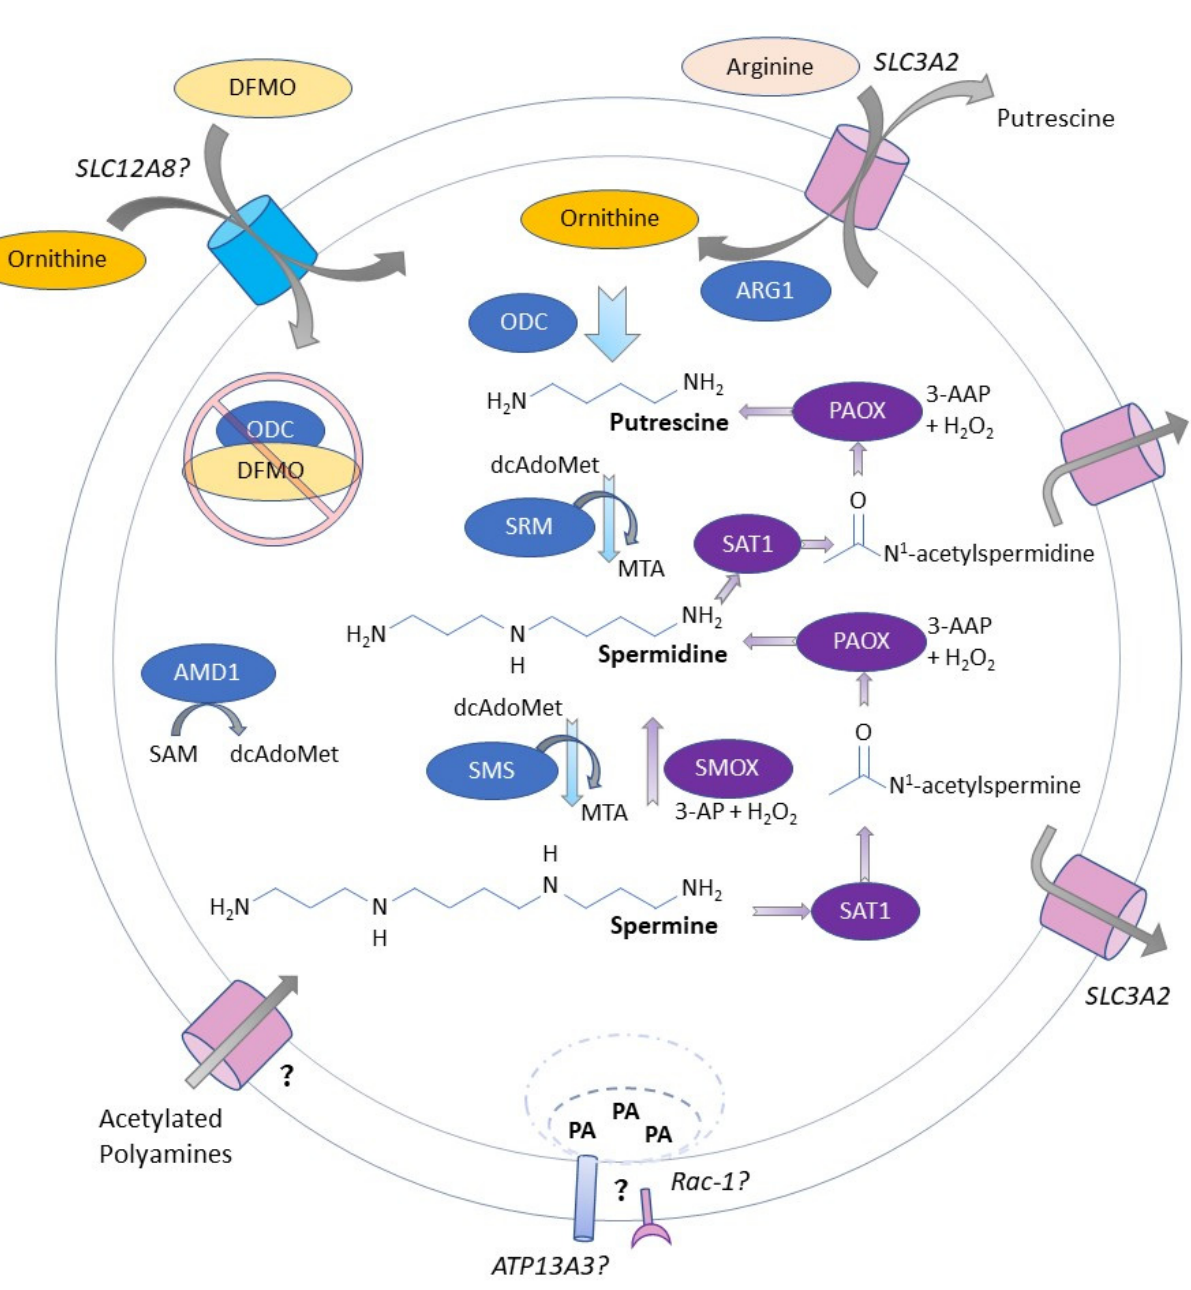
Figure 1. Diagram of polyamine metabolism. Ornithine is generated by the action of arginase I (ARG1) in the urea cycle. Ornithine decarboxylase (ODC) catalyzes the first rate-limiting reaction in polyamine biosynthesis to generate putrescine. Adenosylmethionine decarboxylase (AMD1) removes the car- boxyl group from S-adenosylmethionine (SAM) to generate decarboxylated S-adenosylmethionine (dcAdoMet). Spermidine synthase (SRM) then adds an aminopropyl moiety from dcAdoMet to putrescine to generate spermidine. Spermine synthase (SMS) adds an additional aminopropyl moiety to spermidine to generate spermine. Polyamine biosynthetic enzymes are shown in blue. Spermine oxidase (SMOX), a cytoplasmic and nuclear oxidase, directly oxidizes spermine to spermidine and generates 3-aminopropanal (3-AP) and hydrogen peroxide (H 2 O 2 ) as byproducts. Spermidine/spermine N1-acetyltransferase 1 (SAT1) adds an acetyl group to the N 1 position of